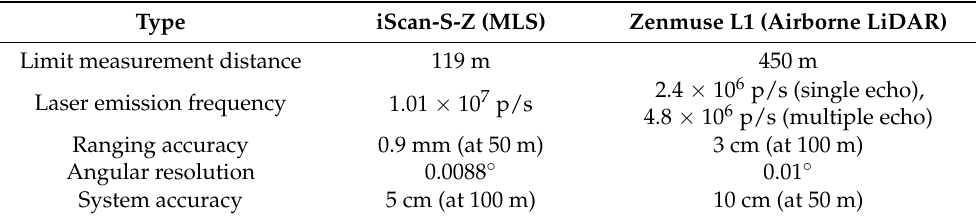
Table 1. Measurement parameters of the MLS system and UAV airborne LiDAR equipment.